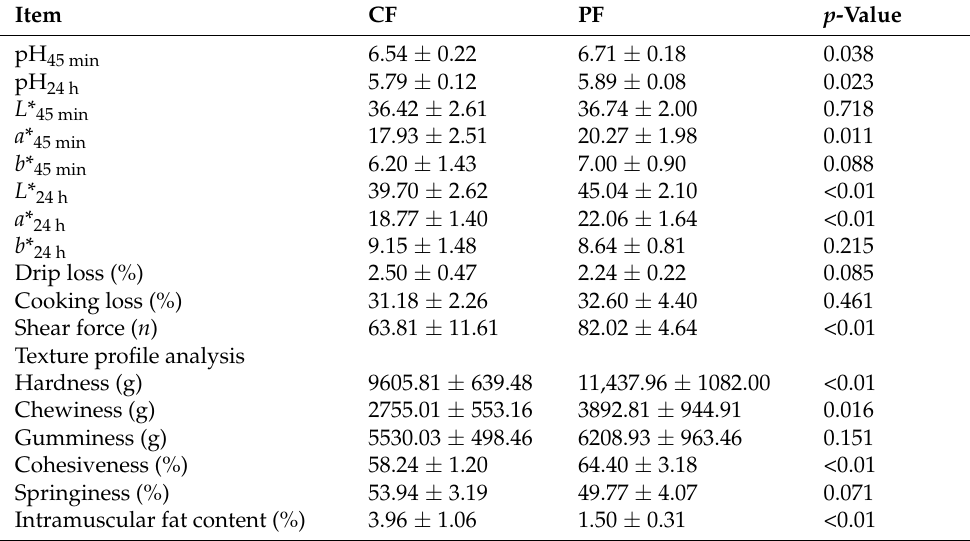
Table 1. Meat quality characteristics and intramuscular fat content in concentrate-fed (CF) and pasture-fed (PF) groups ( n =